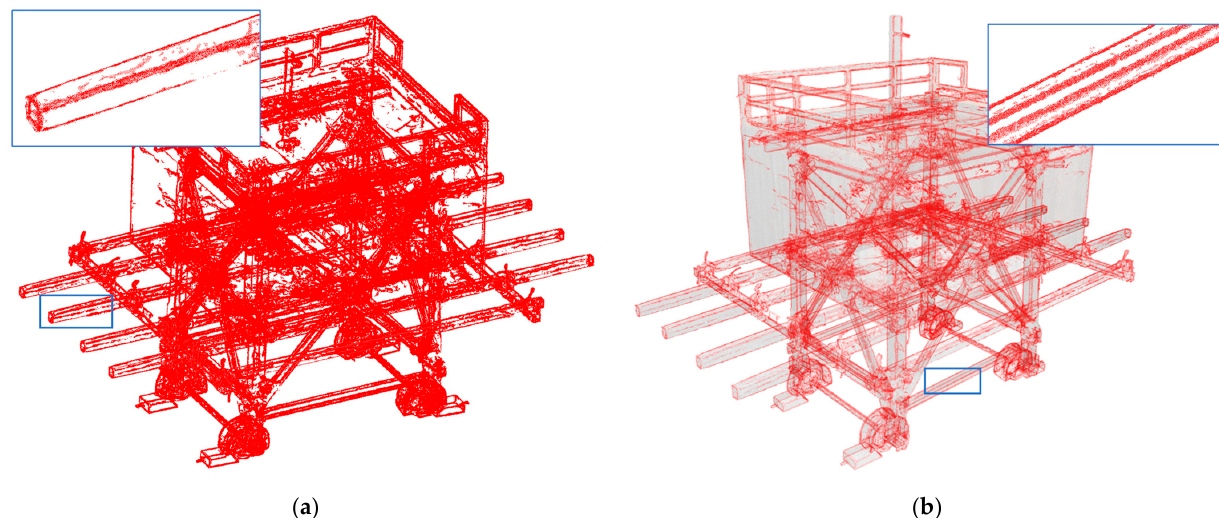
Figure 17. ( a ) Edge points of the point cloud data in Figure 16. The set of edge points is created by extracting points by using linearity L λ and adopting the type (b) function and then applying our upsampling network. ( b ) Edge-highlighted transparent visualization using the points of (a) and the original 3D-scanned points in Figure 16.